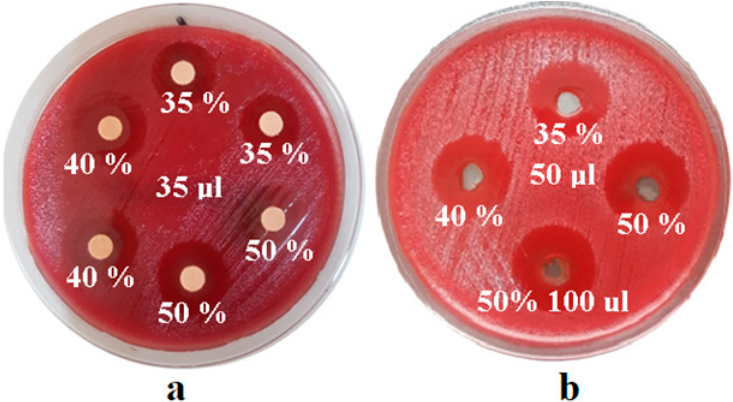
Figure 1. Inhibition diameters of Peptostreptococcus anerobius culture on inoculation of 35 µl of 35%, 40% and 50% extract ( a ) and diameters of inhibition zones of Peptostreptococcus anaerobius culture on inoculation of 50 µl of 35%, 40% and 50% extract, as well as 100 µl extract 50% ( b ).